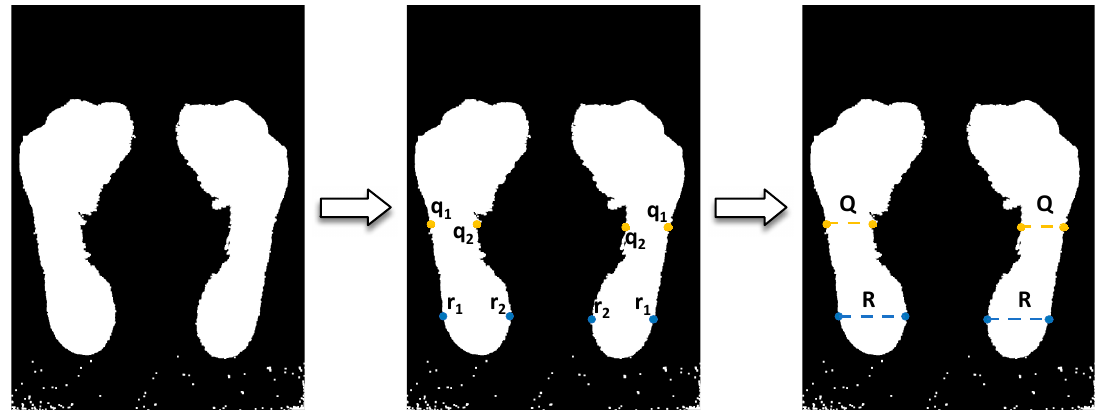
Figure 6. The process of the Staheli arch index calculation.